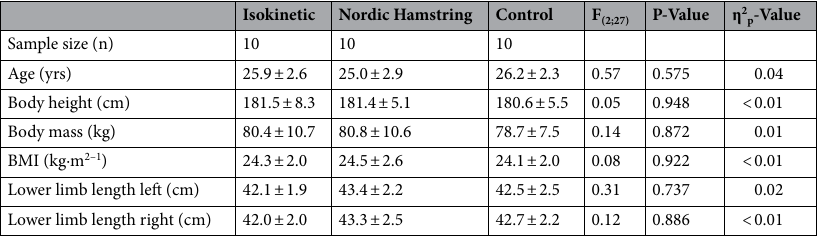
Table 1. Physical characteristics of participants. Values are express as mean SD; BMI, body mass